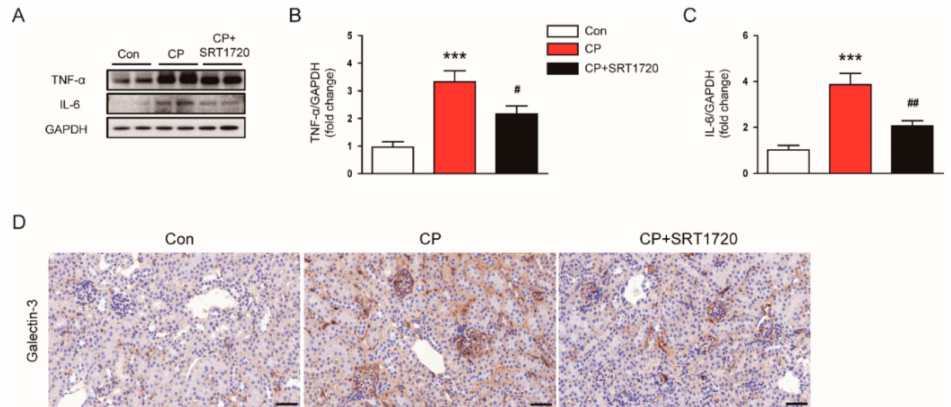
Figure 8. E ff ects of SRT1720 on renal inflammation in mice treated with cisplatin. ( A ) Western blots of tumor necrosis factor- α (TNF- α ) and interleukin-6 (IL-6) levels in kidneys. ( B ) Quantification of TNF- α level. ( C ) Quantification of IL-6 level. ( D ) Representative images of immunohistochemical staining using anti-Galectin-3 antibody. *** p < 0.001 vs. Con. # p < 0.05 and ## p < 0.01 vs. CP.